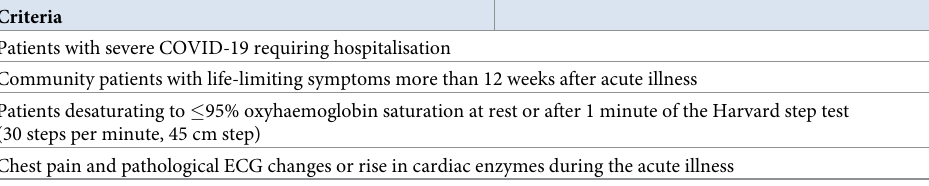
Table 1. Indications for referral to defence COVID-19 recovery service.